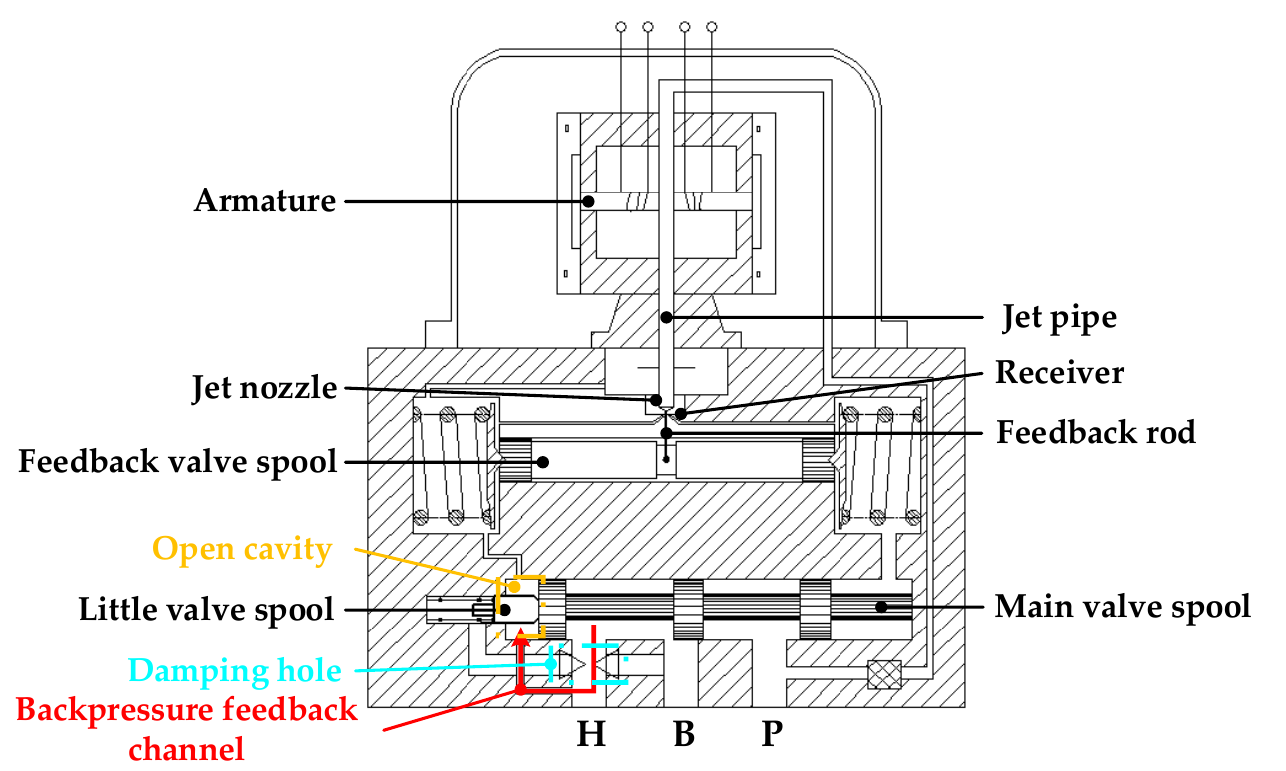
Figure 15. Principle of structure-optimized pressure servo valve. To illustrate the attenuation effect of damping holes on backpressure oscillations, a simulation model of pressure oscillations with damping holes is established in the Amesim software, as shown in Figure 16.